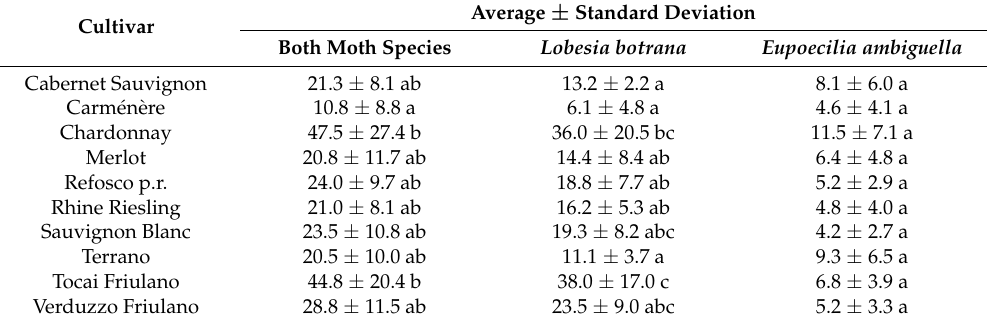
Table 1. Comparison of the average number of larval nests per year (four years) recorded on 100 bunches in the 10 cultivars. Different small letters among cultivars within each column indicate significant differences according to Tukey’s test at the 0.05 level.